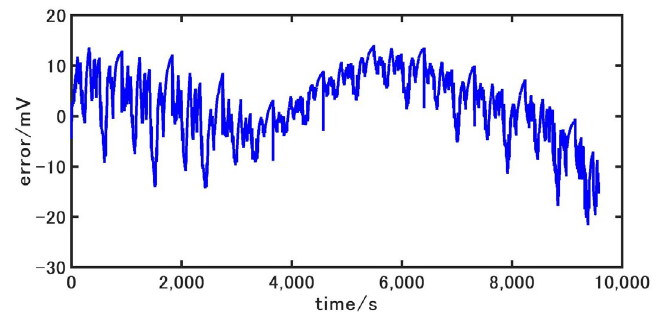
Figure 14. Errors of Terminal Voltage under BJDST Driving Condition.